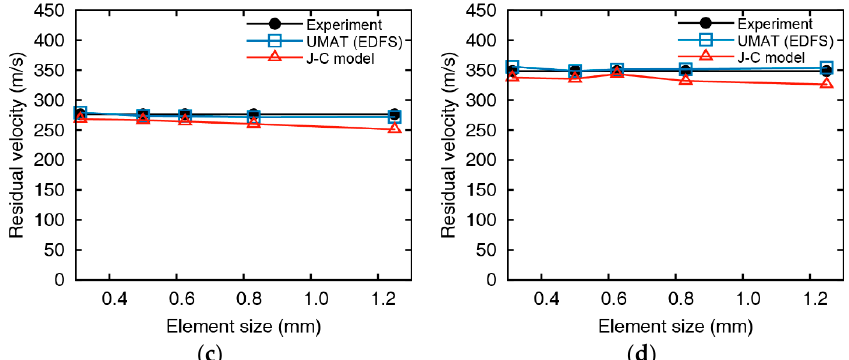
Figure 11. Comparison between impact test and numerical analysis at an initial velocity of ( a ) 163.2, ( b ) 187.4, ( c ) 298.8, and ( d ) 372.8 m / s ( t pl = 5 mm).